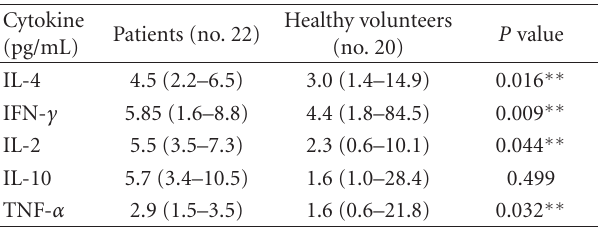
Table 5: Comparison of serum cytokine in chronic HBV patients and healthy